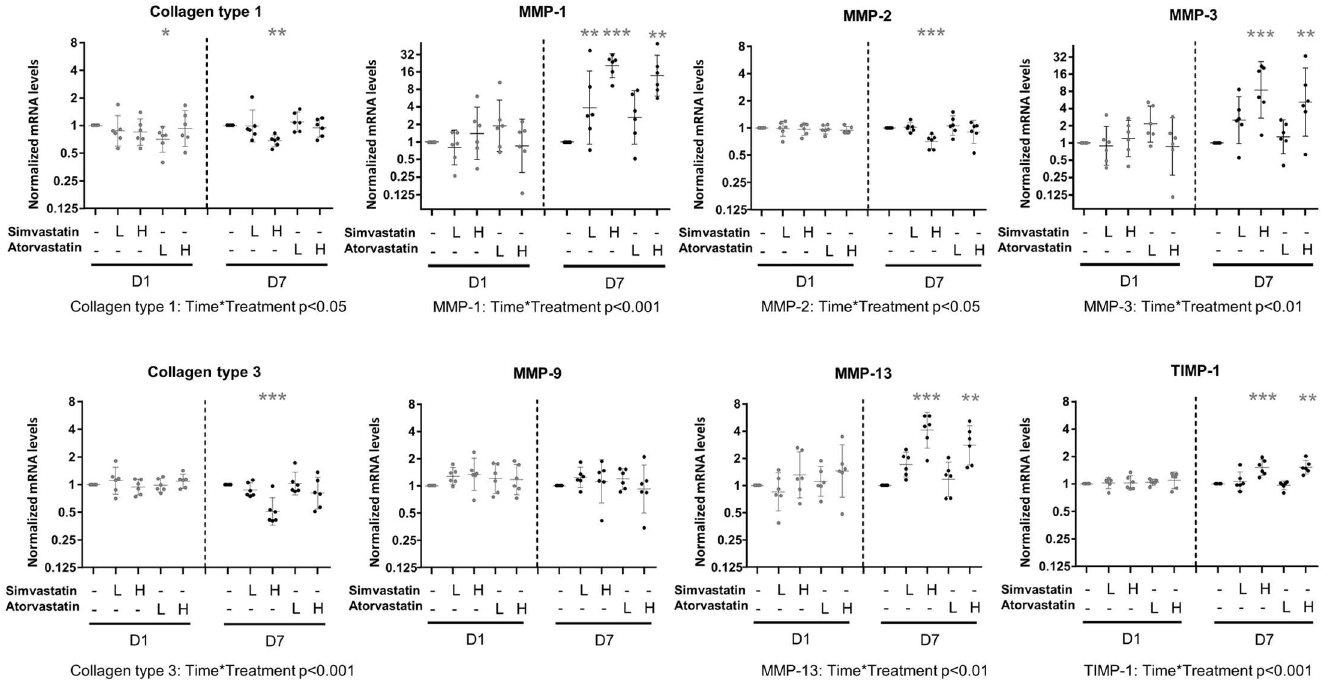
Fig 6. Gene expression analysis: Effect of treatment on collagen, MMPs and TIMP-1. Gene expressionafter 1 or 7 days of statin treatment. The sampleswere analyzedfor collagens, MMPs and TIMP-1. Low dose (L) statin treatment corresponds to 0.05 μ Mof either simvastatin or atorvastatinand high dose (H) corresponds to 0.5 μ M. The DMSO-control is set as baseline,and mRNA expressionin constructs treated with statins are shown relativeto DMSO-control for each cell line and day. Significantchangesfrom DMSO-control are indicatedby * (p < 0.05), ** (p < 0.01), and *** (p < 0.001). Data is presented on a logarithmicy scale as geometric means ± 95% confidenceinterval (CI). Individual donor-specific cell lines are represented by dots. Significant interactionin the repeatedmeasures2-way ANOVA (time * treatment) are indicatedbeloweach